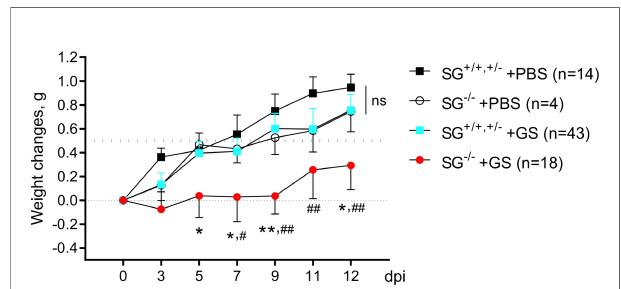
FIGURE 1 | Weight scoring in and SG +/+, +/- and SG -/- mice infected with Giardia intestinalis . Young ( ≈ 11 weeks old) congenic SG +/+ , SG +/- , SG -/- C57Bl/ 6 littermate female and male mice without antibiotic treatment were challenged by oral gavage with PBS or with 10 6 Giardia intestinalis trophozoites in PBS Weight data and feces were collected every second or third day until endpoint, and weight changes were normalized to the Initial weight at day 0. Weight data of the PBS-challenged SG +/+,+/- (n = 14) and SG -/- (n = 4) mice and pooled weight data of all Giardia intestinalis infected SG +/+,+/- (n = 43) and SG -/- (n = 18) mice from two independent infection experiments are shown (see Supplementary S1 ). For comparisons between all groups and days a Mixed- effect analysis was performed. ns, non-signi fi cant, P values * <0.05 and **<0.01 for SG -/- +GS vs SG +/+,+/- +GS mice, and # <0.05 and ## <0.01 for SG -/- +GS vs SG +/+,+/- +PBS mice are